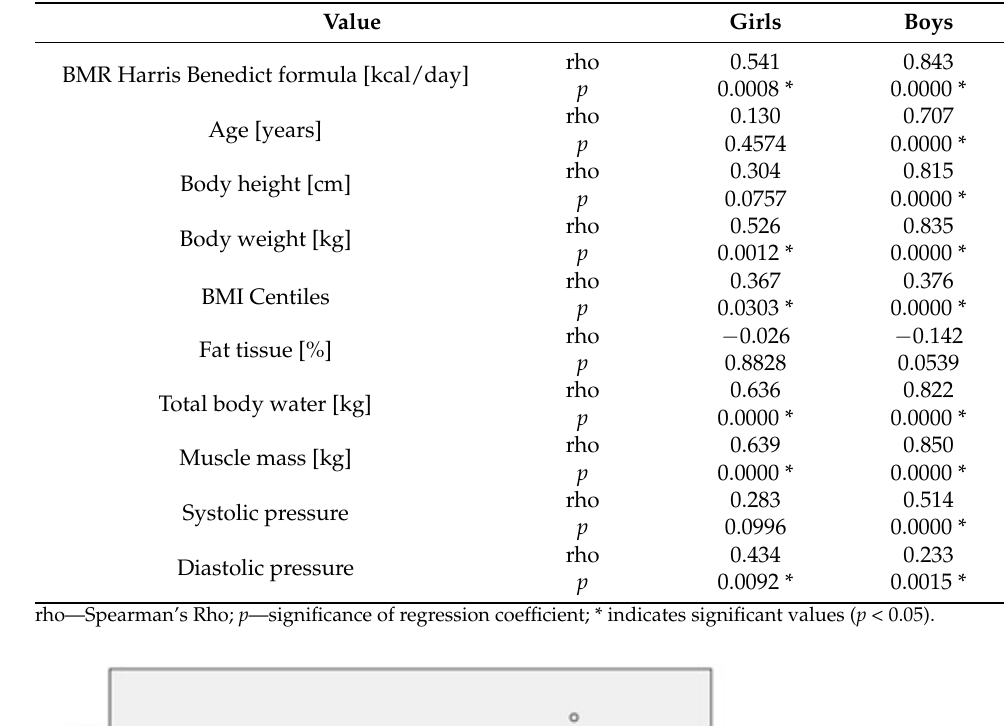
Table 2. Correlation between the resting energy expenditure (REE) and the selected factors.